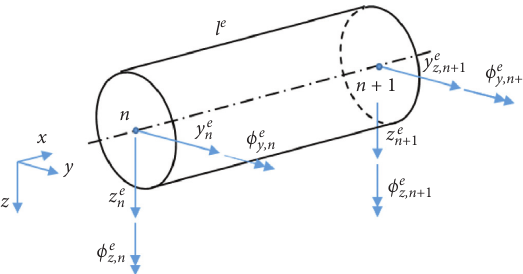
Figure 3: Schematic beam element for rotor modeling.